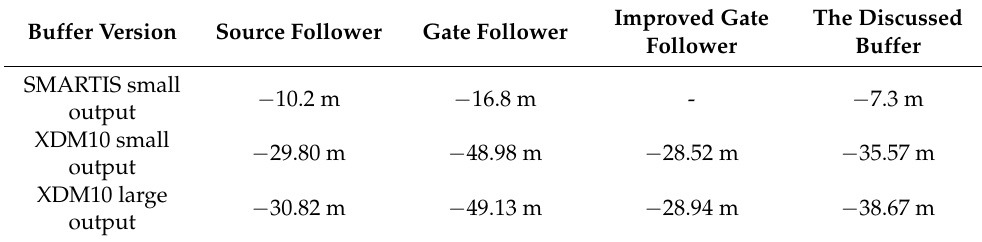
Table 1. Comparison of voltage gain [dB ( V / V )] for different schematic stage implementations of the source follower, gate followers and the discussed buffers.